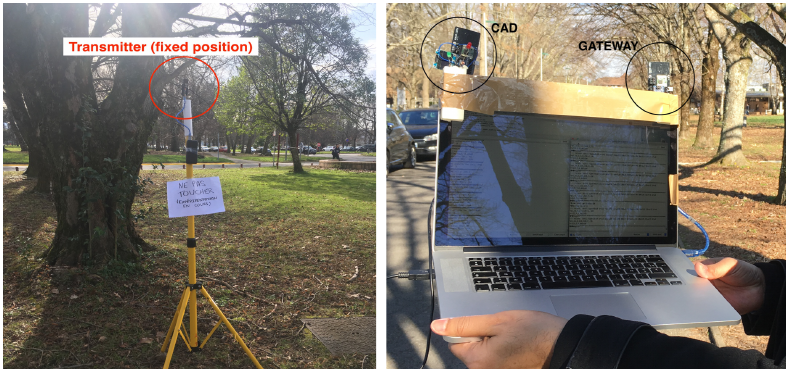
Figure 2. CAD Transmitter and gateway.